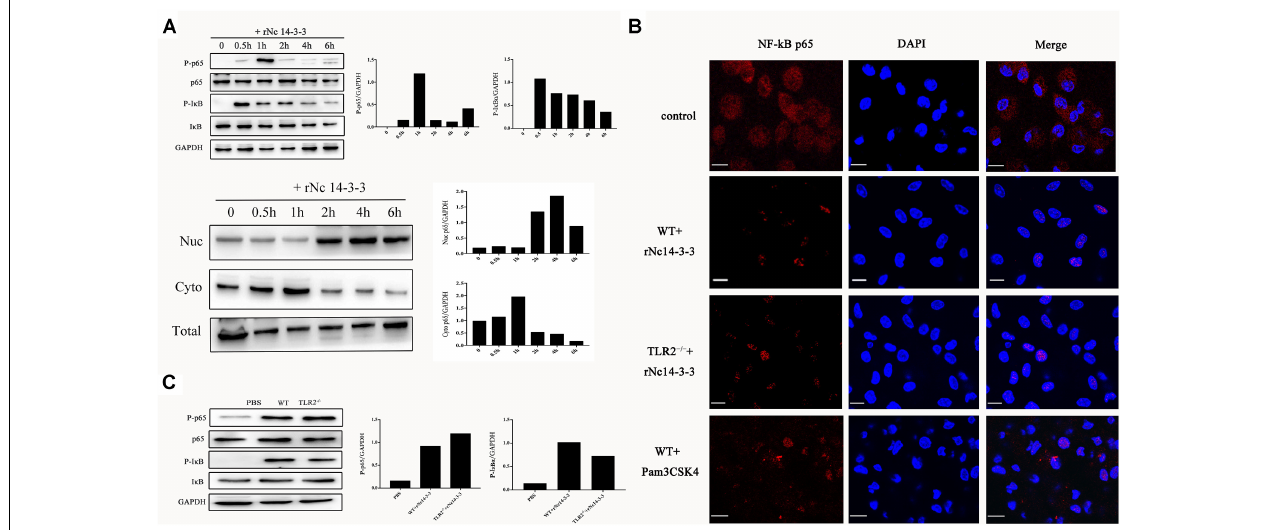
FIGURE 8 | Recombinant Nc14-3-3 induces the translocation of NF- κ B/p65 subunits to the nucleus. ( A , Top) WT mouse PMs were incubated with rNc14-3-3 for the indicated times and the phosphorylation levels of p65 and I κ B were determined by Western blotting and relative gray intensity analysis. (Bottom) WT mouse PMs were incubated with rNc14-3-3; then, cytoplasmic and nuclear proteins were extracted separately. NF- κ B/p65 protein levels were reduced in the cytoplasm but increased correspondingly in the nucleus at 2 h. (B) The effects of rNc14-3-3 or Pam3CSK4 on the translocation of NF- κ B/p65 from the cytoplasm to the nucleus in the WT and TLR2 − / − group were observed after incubation with rNc14-3-3 through laser scanning confocal microscopy. (C) WT and TLR2 − / − mouse PMs were incubated with 50 µ g/ml of the rNc14-3-3 protein for 1 h, and the phosphorylation levels of p65 and I κ B were determined by Western blotting and relative gray intensity